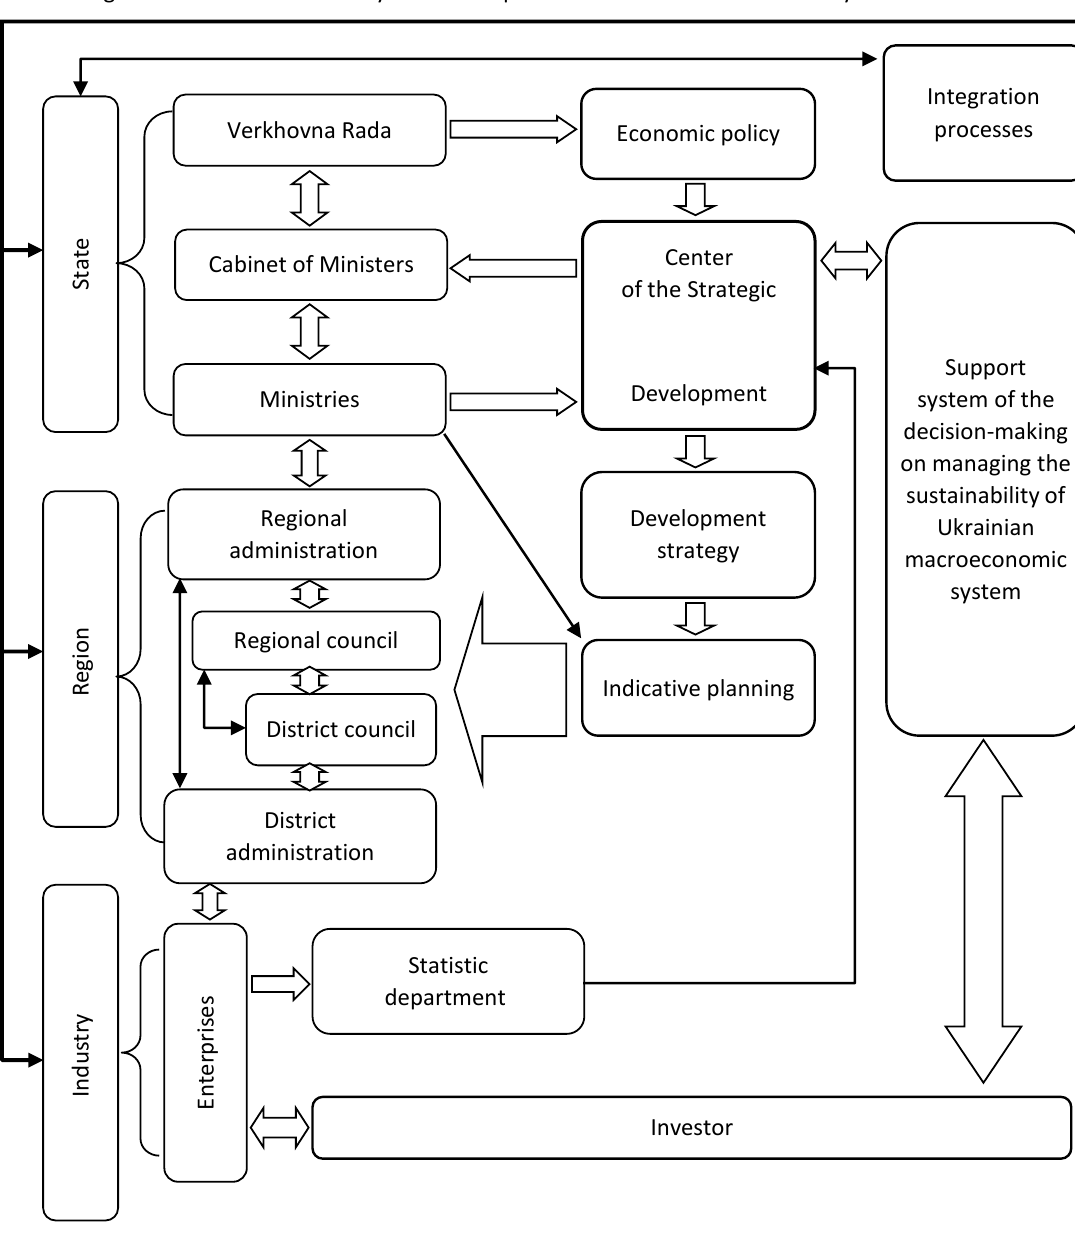
Figure 3. Organizational structure of the model for managing the sustainability of the